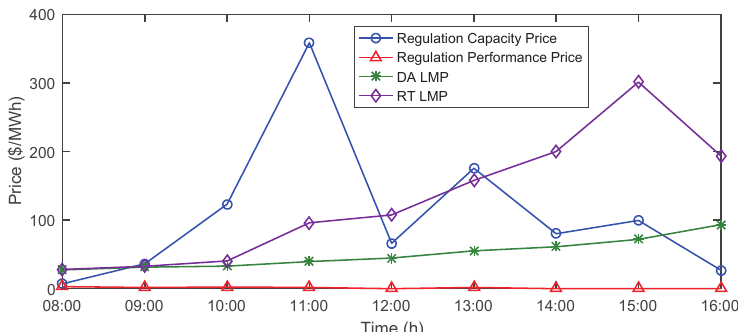
Figure 6. The forecasts of energy and regulation market prices.